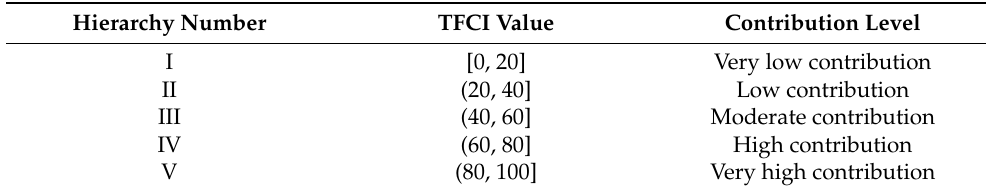
Table 2. Five hierarchy numbers and their contribution levels of texture feature contribution in- dex